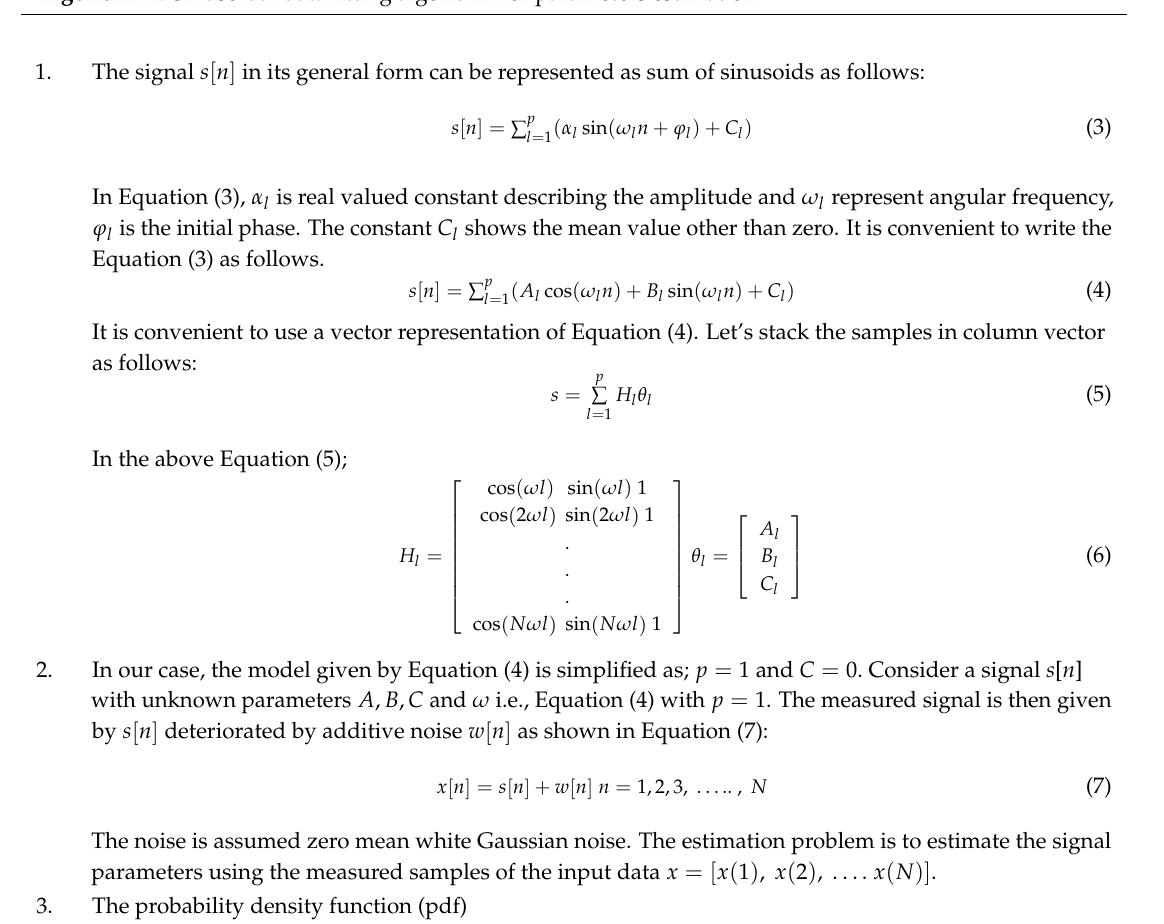
Algorithm 1: Sinusoidal data fitting algorithm for parameters